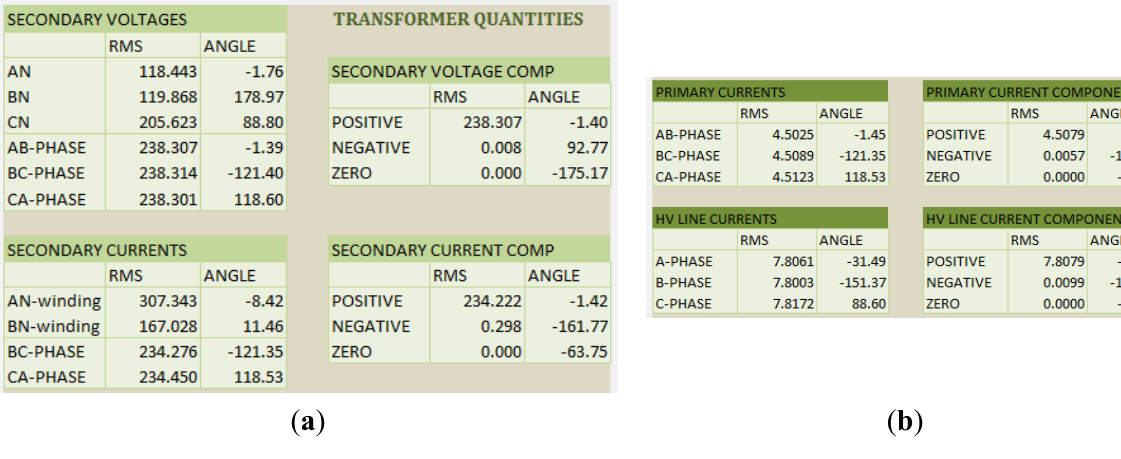
Figure 10. 4WD transformer voltages and currents after compensation: ( a ) secondary side; ( b ) primary